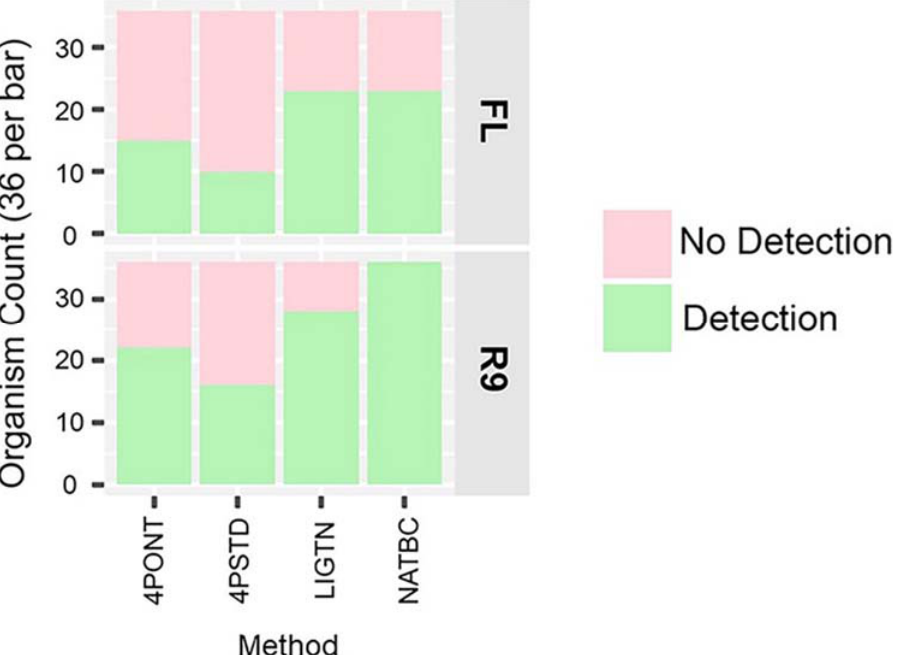
Figure 3. Detected organism counts. Counts for each method out of a total of 36, per method per flow cell type (Green is detected, Pink is not detected). Detection in this analysis means all expected amplicons had a filtered aligned read count ≥ 1. NTCs are not included.